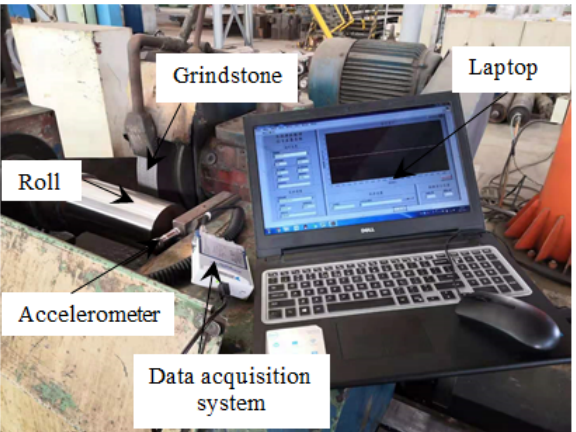
Fig. 4. Illustration of experiment